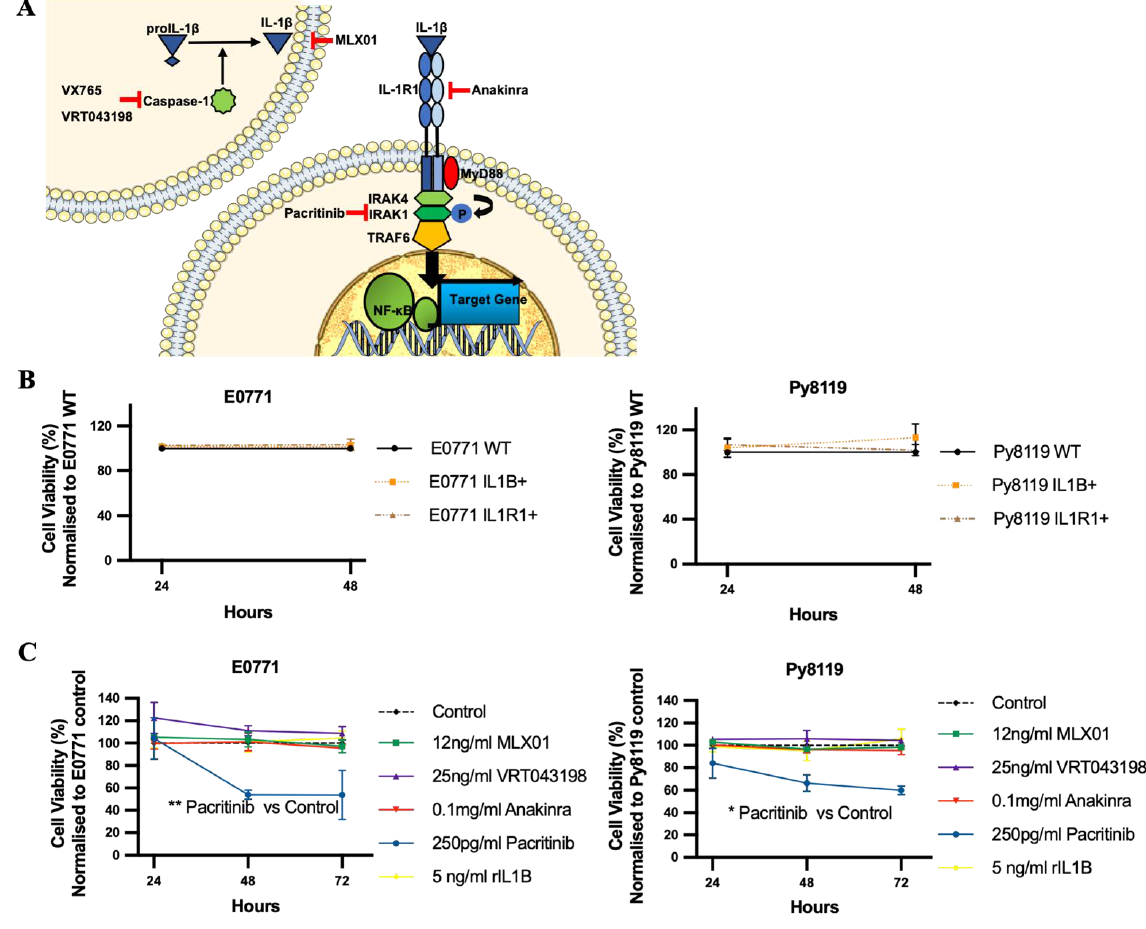
Figure 1. The effects of IL1β overexpression and inhibitors of the IL1β pathway on viability of E0771 and breast cancer cells in vitro. ( A ) Cartoon showing where VX765/VRT043198 (Caspase-1 inhibitors), MLX01 (IL1β secretion inhibitor), Anakinra (IL1R antagonist) and Pacritinib (IRAK1 inhibitor) inhibit the IL1β signalling pathway. ( B , C ) Effects of overexpression of IL1β (IL1B+), overexpression of IL1R1 (IL1R1+), inhibition of IL1β (12 ng/mL MLX01), inhibition of Caspase-1 (25 ng/mL VRT043198), inhibition of IL1R (0.1mg/kg Anakinra) and inhibition of IRAK1 (250 pg/mL Pacritinib) and recombinant IL1β (5 ng/mL) on tumour cell viability, normalised to control. All experiments are from three biological experiments and their graphs represent mean + SD, * p < 0.05, ** p < 0.01. Our previous study showed that tumour- derived IL1β was much more potent at pro- moting the migration of MDA-MB-231 and MCF7 brea st cancer cells compared with IL1β from the microenvironment [2]. To validate this result in the cell lines used for the current study, we genetically manipulated E0771 and Py8119 cells to increase the expression of IL1β, or IL1R1 and used scratch assays t o compare their migratory ability with control cells as well as control cells stimulated with recombinant mouse IL1β (microenvironment derived IL1β). We found that 5 ng/mL mouse recombinant IL1β did not promote the mi- gration of breast cancer cells, while g enetic overexpression of IL1β increased the migration of E0771 ( p = 0.003) and Py8119 cells ( p = 0.0776) (Figure 2A). Moreover, genetic overex- pression of IL1R1 had no effect on the migration of either cell line (Figure 2A). Importantly pharmacological inhibition of IL-1 signalling using 12 ng/mL MLX01 ( p = 0.0245, p = 0.0103), 25 ng/mL VRT043198 ( p = 0.0028, p = 0.0093) or 0.1 mg/mL Anakinra ( p = 0.0040, p